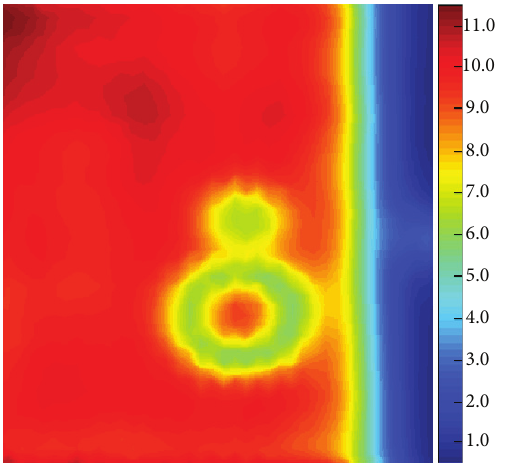
Figure 4: Spectral content transmission image (0.01 THz to 0.10THz) of tile sample “ A1-8 ” with air- fi lled voids taken at a grid resolution of 2 mm. Transmitted energy is shown colored from blue (low transmission) to red (high transmission) with the scale shown in arbitrary units. Both circular voids are discernible. The large and small cylindrical voids of this sample are 2.2cm and 0.75cm in diameter, respectively, with a separation of 0.8cm. The transmission cut-o ff on the right hand side of the image was caused by metal apparatus used to hold the tile sample.